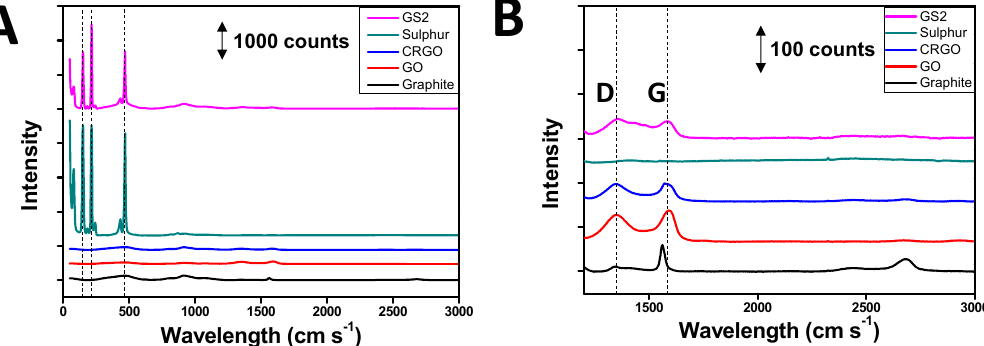
Figure 5. ( A ) Raman spectra of the sulfur band in the materials; ( B ) Raman spectra of the D and G band region of the carbon stretching mode.